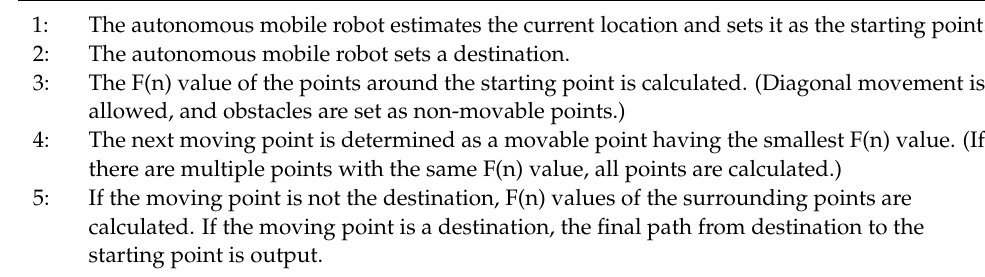
Algorithm 1 Main steps of path